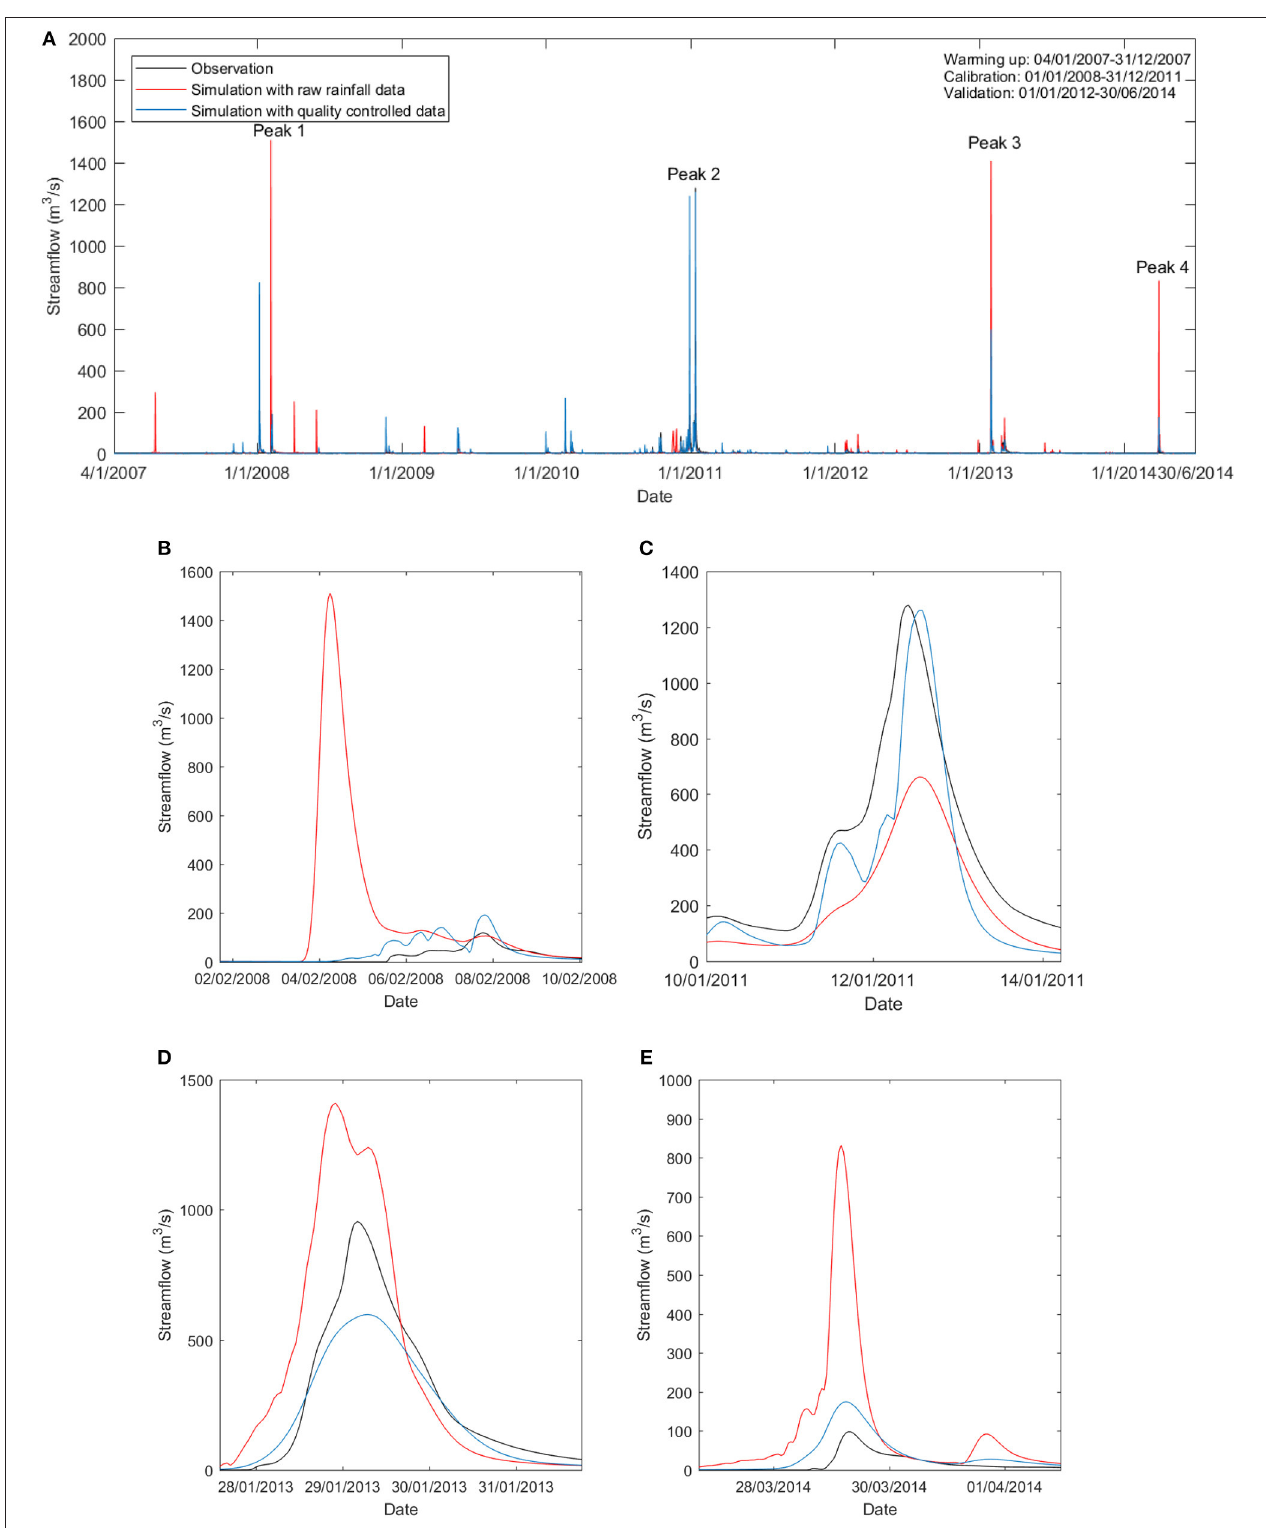
FIGURE 3 | Streamflow of observation and simulation forced by raw and quality-controlled rainfall (IDW interpolation). (A) Streamflow during the entire timeline; (B) Streamflow peak 1 in February 2008; (C) Streamflow peak 2 in January 2011; (D) Streamflow peak 3 in January 2013; and (E) Streamflow peak 1 in March 2014.